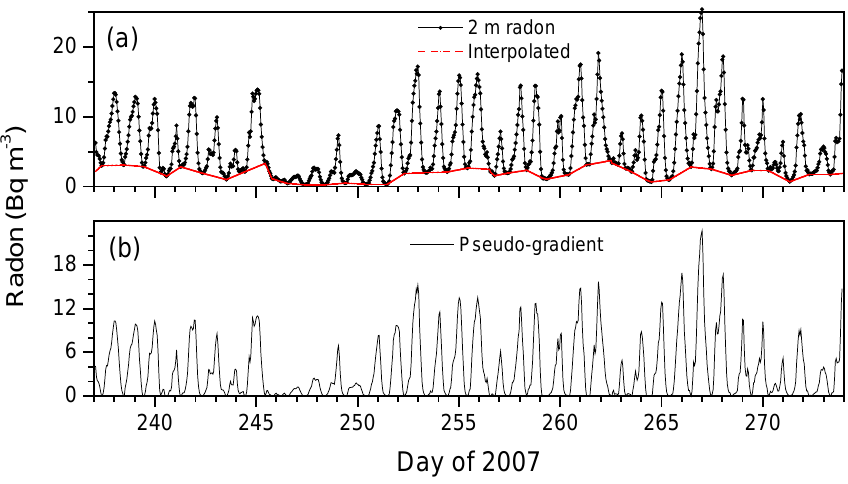
Figure 4. (a) Hourly radon observations at Richmond in September 2007, and afternoon interpolated values, and (b) the Richmond radon gradient (difference between observed and interpolated radon